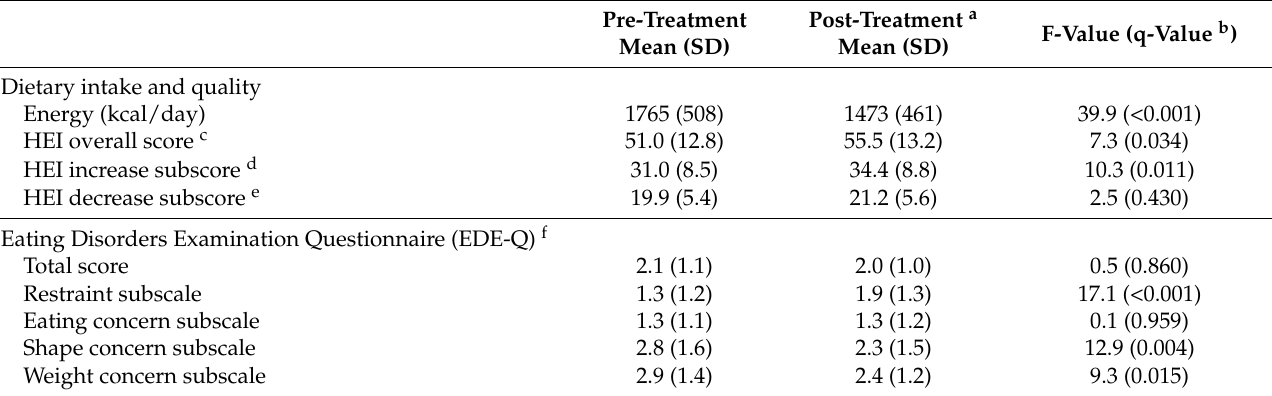
Table 2. Daily energy intake, dietary quality, and eating pathology values at pre- and post-treatment, following a 4-month multicomponent obesity intervention in N = 82 adolescents. Test statistics are from repeated measures analysis of variance models examining changes from pre- to